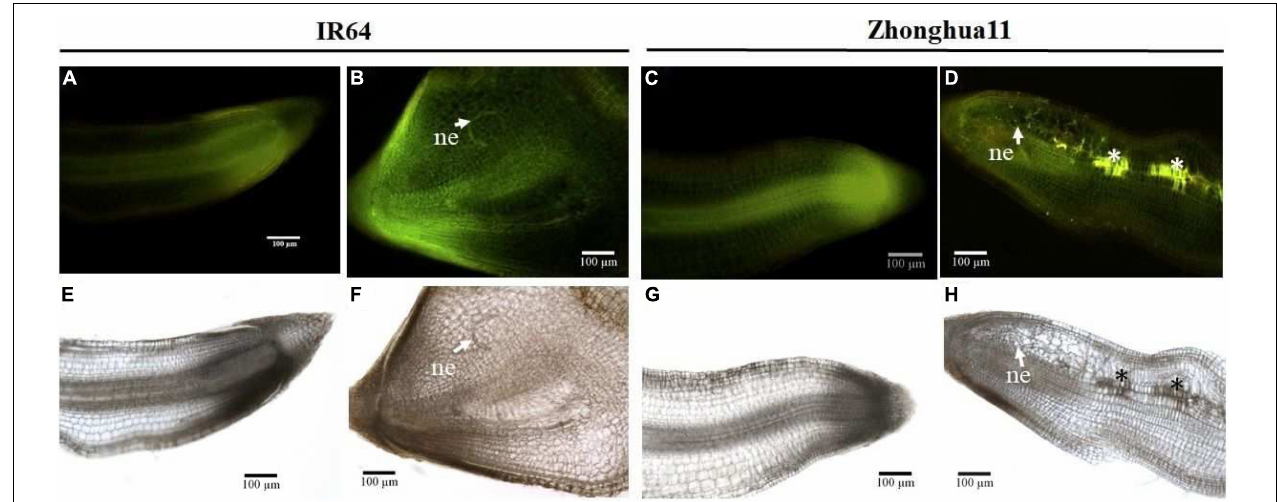
FIGURE 2 | Reactive oxygen species accumulation in Zhonghua 11 roots was observed 2 days after Meloidogyne graminicola infection. Longitudinal root sections of healthy control and M. graminicola -inoculated roots of both susceptible IR64 and resistant Zh11 parents were observed at 2 dpi under UV light (A–D) , with glowing signal revealing the presence of phenolic compounds, or under white light (E–H) after DAB staining, with the formation of brown precipitates indicating accumulation of H